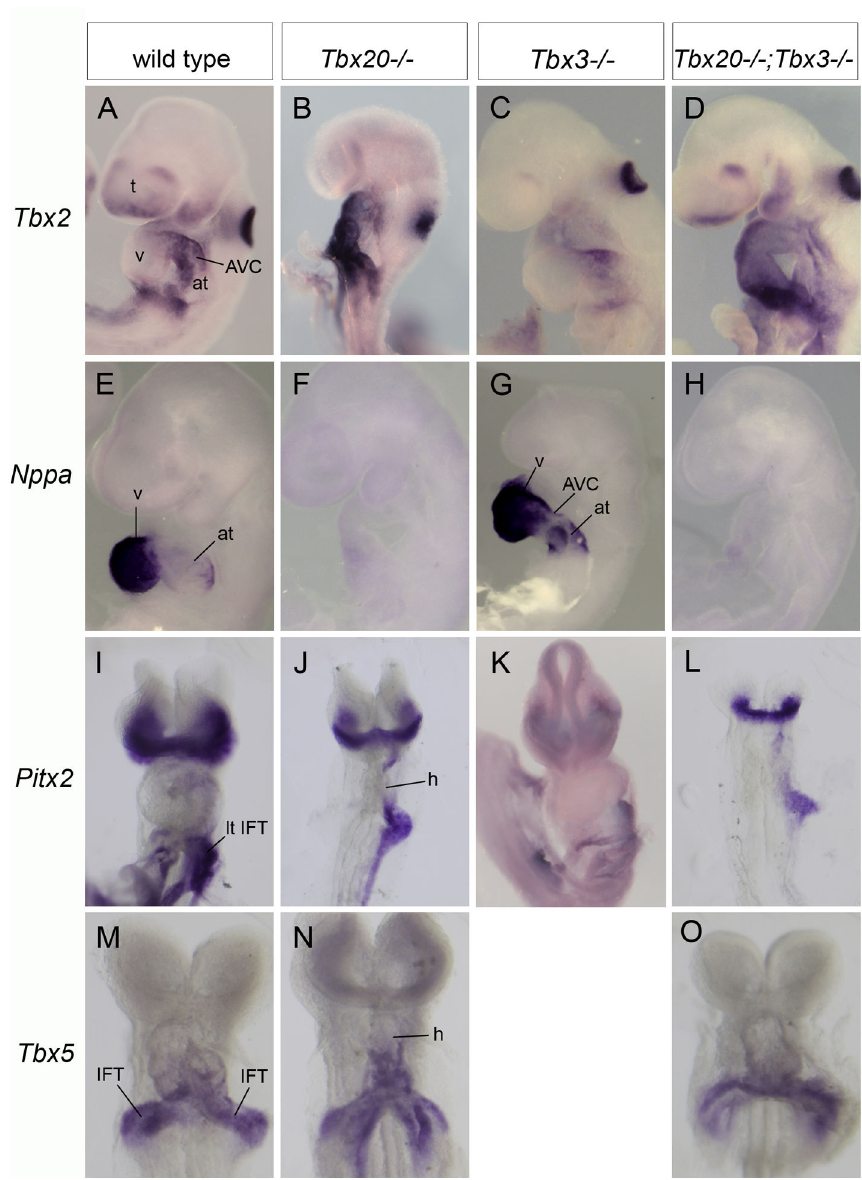
Figure 3. Cardiac marker gene expression suggests that Tbx20 -/- ; Tbx3 -/- double homozygous mutants show a Tbx20 -/- phenotype. Whole mount ISH left (A–H) or ventral (I–O) views of the head and heart of stage-matched wild type, single and double mutant embryos showing expression of Tbx2 (E9.25; A-D), Nppa (E9.25; E-H) , Pitx2 (E8.5; I-L) and Tbx5 (E9.25; M-O). Tbx2 is normally expressed in the AVC in wild type and Tbx3 -/- hearts but is ectopically expressed in Tbx20 -/- and double homozygotes. In Tbx20 -/- and double homozygotes, Nppa expression is severely down regulated in ventricular myocardium, but in Tbx3 -/- hearts it is precociously upregulated in atrial myocardium. There is no change in Pitx2 expression in the left inflow tract in Tbx20 -/- , Tbx3 -/- or double homozygous embryos when compared to wild type. Tbx5 is expressed in the atrioventricular and atrial progenitors in an antero-posterior gradient. There is no change in Tbx5 expression in either Tbx20 -/- or double homozygotes compared to wild type at E9.25. at, atrium; AVC, atrioventricular canal; h, heart; IFT, inflow tract; lt IFT, left inflow tract; t, telencephalon; v, ventricle.